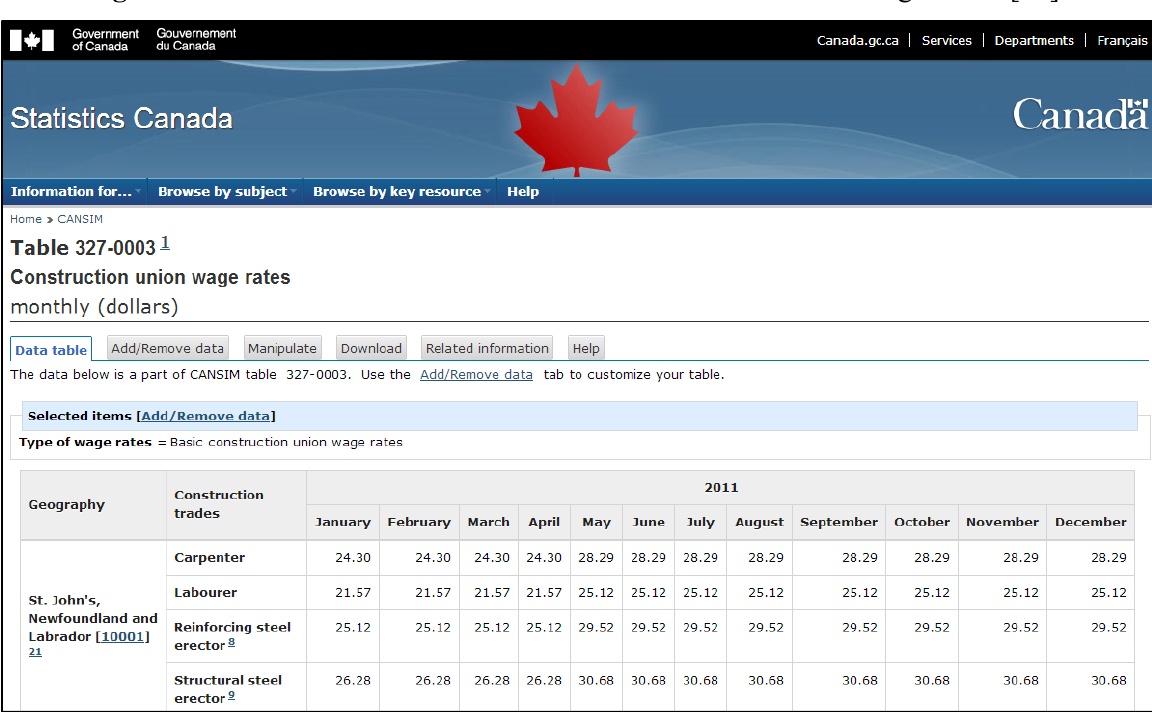
Figure A1. A brief section of the data on the construction union wages rates